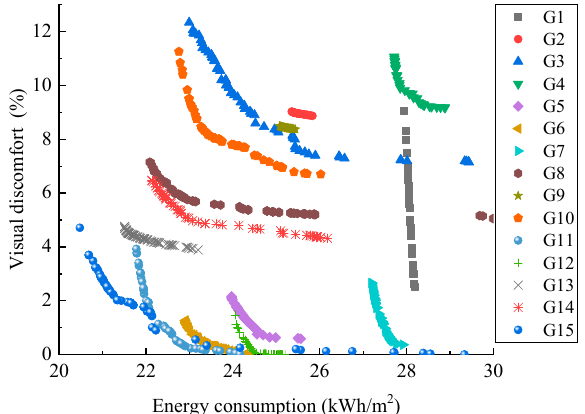
Figure 9. Pareto fronts for different combinations of design parameters.